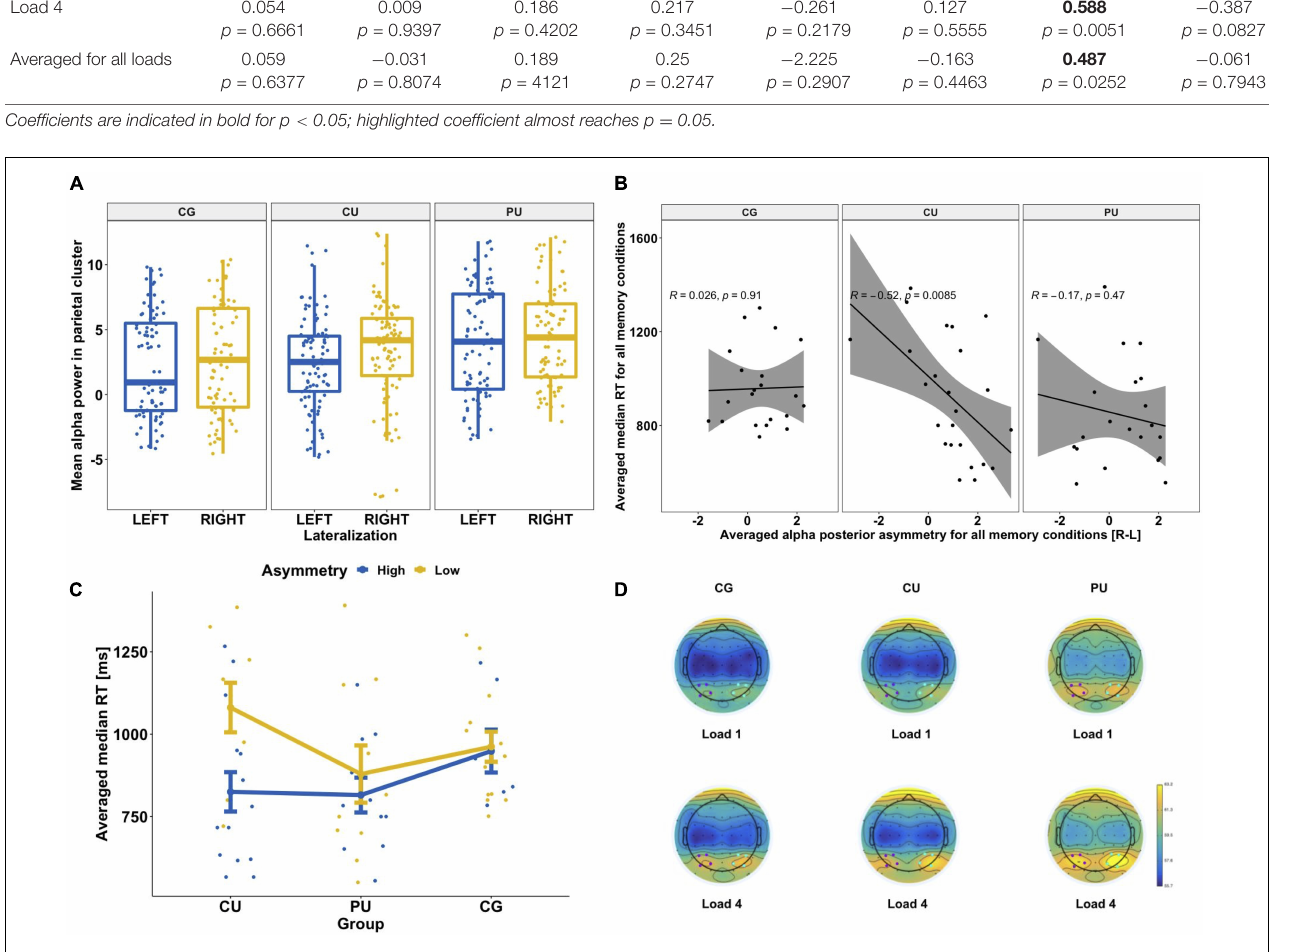
FIGURE 4 | (A) Hemispheric asymmetries in posterior alpha power for each group separately: control group (CG), cannabis users (CU) and polydrug users (PU). There was significantly higher alpha power in the right posterior cluster [P4, P6, PO4, and PO8] than left [P3, P5, PO3, and PO7] for each group. (B) Association between posterior alpha asymmetry averaged across all memory loads and averaged reaction time across all memory conditions (for correct answers only) for each group separately. (C) Differences in RT depending on alpha power asymmetry level (high vs low) for three groups: CG, CU and PU. Both RT and alpha asymmetry power were averaged across all memory loads. (D) Topographic representation of alpha power (8–13 Hz) distribution during WM maintenance phase (1,000–2,450 ms) for two memory loads (1 and 4) for each group. Blue dots indicate the location of the right posterior cluster and purple dots indicate the location of the left posterior